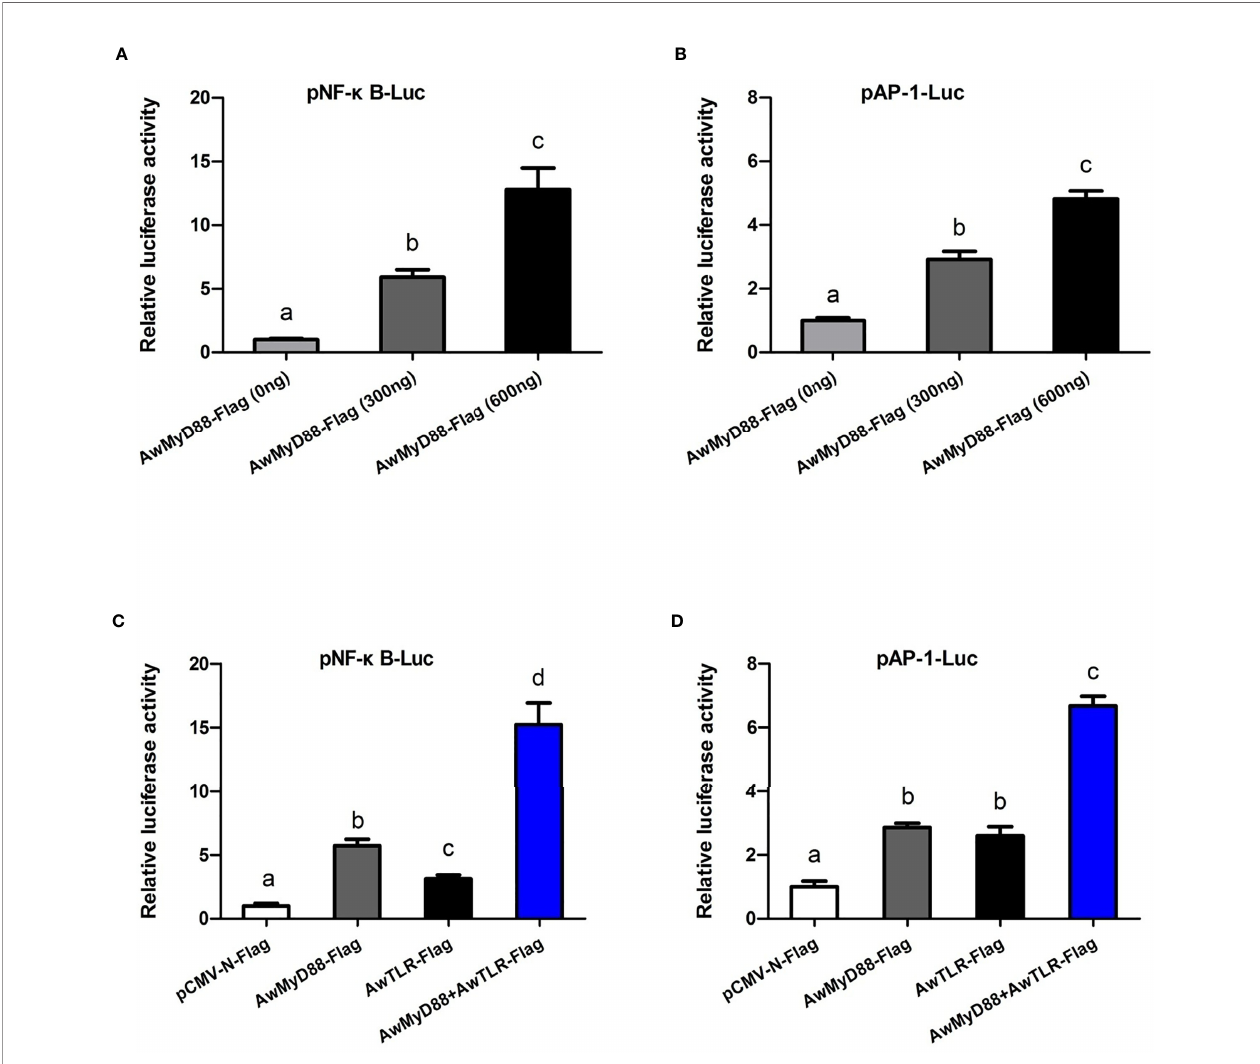
FIGURE 9 | Effects of Aw MyD88 overexpression on the activity of the NF- k B (A, C) or AP-1 (B, D) reporter genes in HEK293T cells. The expression plasmids Aw MyD88-Flag/ Aw TLR-Flag were cotransfected with NF- k B/AP-1 luciferase reporter plasmids and the pRL-TK Renilla luciferase plasmid into HEK293T cells using Lipofectamine 2000 Transfection Reagent. Fire fl y and Renilla luciferase activities were detected in cell lysates 48 h after transfection. Relative luciferase activities were calculated by normalizing to the pRL-TK value. The results are represented as the mean values of three independent experiments ( N = 3), and error bars represent standard deviations. Different letters indicate signi fi cant differences compared with other groups ( P <